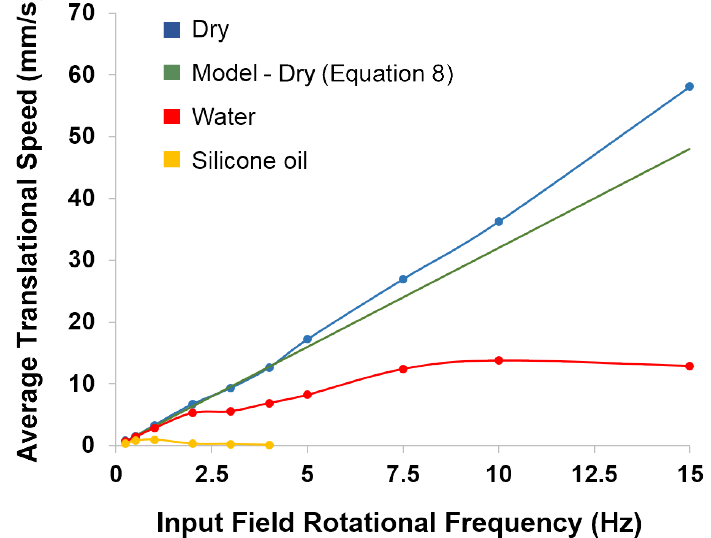
Figure 9. Experimental and modeled average translational speed under varying field rotational frequencies for various conditions. Results also shown in Supplemental Video